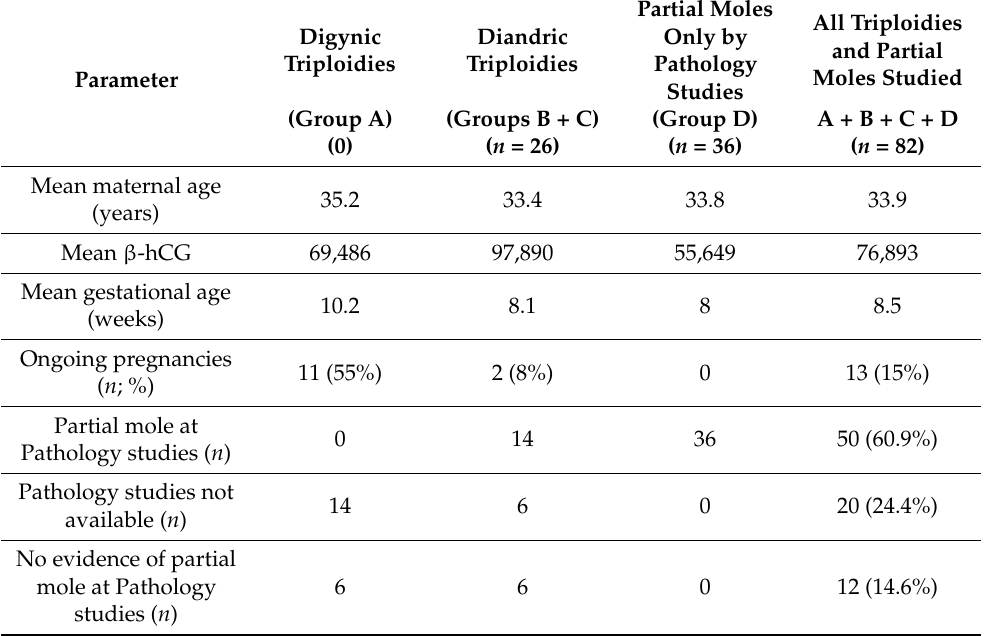
Table 2. Pregnancy characteristics of the two